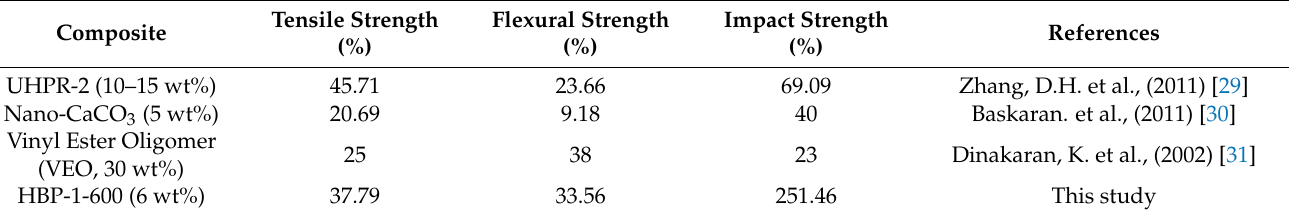
Table 5. The increased proportion of UPR composites with different fillers compared with neat UPR.